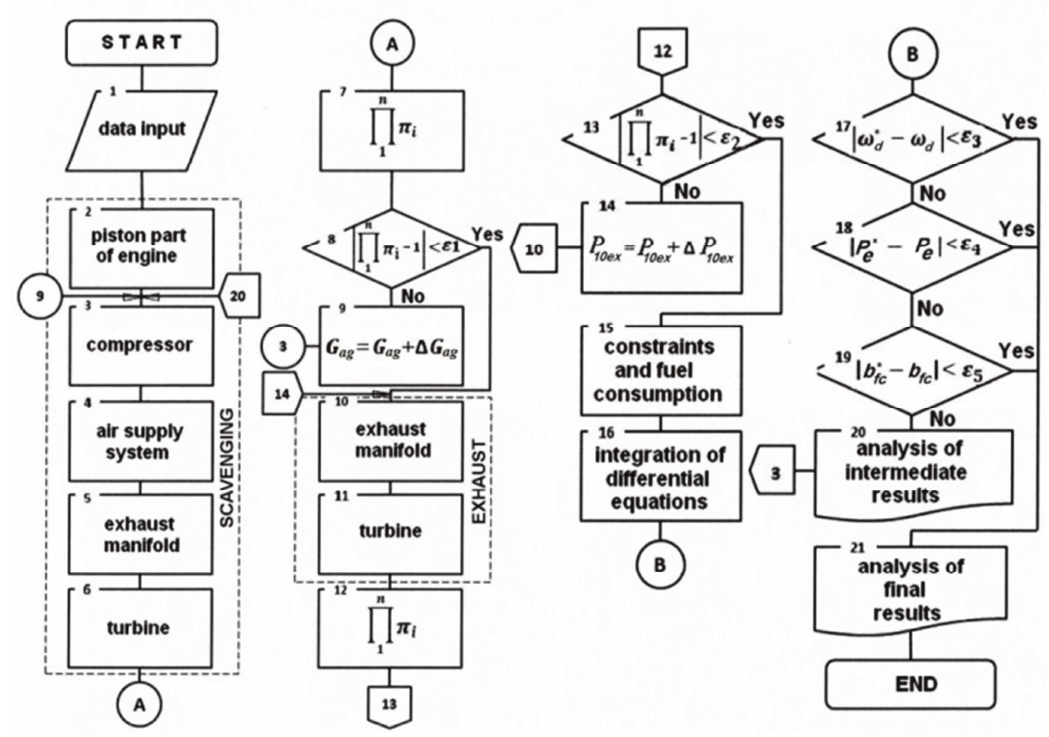
Fig. 3. Block diagram of calculation algorithm of transient process for diesels with pulse